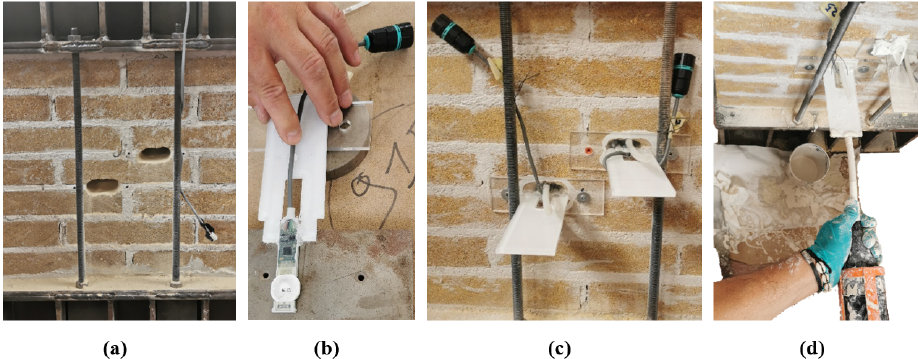
Figure 5. Operating phases for the second post-installation system (P2) of the sensors: ( a ) hole drilling; ( b ) fixing the sensor on a plexiglass plate; ( c ) sensors placement by using a plexiglass support; ( d ) hole